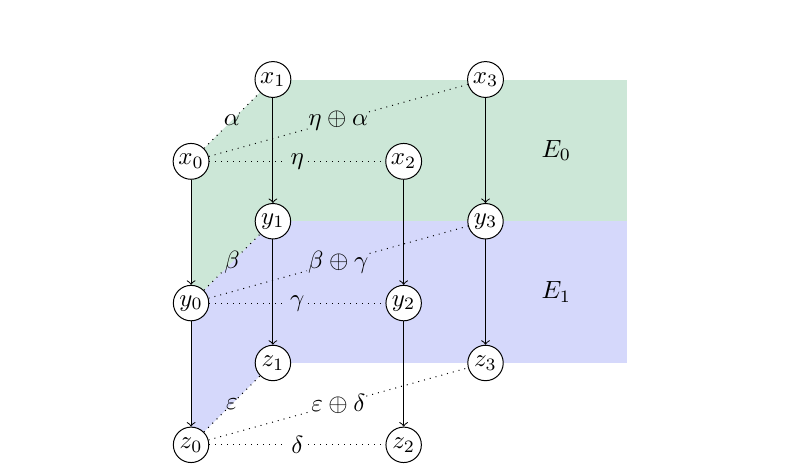
Figure 2: Outline of a simple boomerang attack in the d -difference view. The differences v and w are allowed to take any value